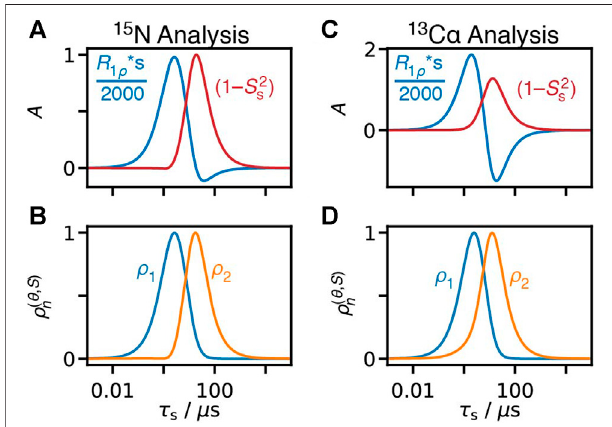
FIGURE 13 | Behavior of fi tting R 1 ρ data to an offset and a fi xed correlationtime. (A) showstheoffsetterm, R 0 1 ρ ,dividedby2000,andtheorder parameter for the slow correlation time, (cid:10) 1 − S 2 s (cid:11) resulting from fi tting calculated relaxation rate constants as a function of correlation time to Eq. 36 . Experiments are 15 N R 1 ρ acquired with MAS frequency of 60 kHz and spin-lock strengths of 11, 16, 25, 38, and 51 kHz, and τ s is fi xed at 18.5 μ s. (B) shows detector sensitivities optimized using the samedata set. (C) shows R 0 1 ρ divided by 2000 and (cid:10) 1 − S 2 s (cid:11) for 13 C R 1 ρ acquired with MAS frequency of 60 kHz and spin-lock strengths of 9, 18, 35, and 48 kHz, as well as an additionalexperimentwithMASfrequencyof40 kHzandspin-lockstrengthof 25 kHz τ s is fi xed at 7.0 μ s. (D) shows detector sensitivities optimized using the same data